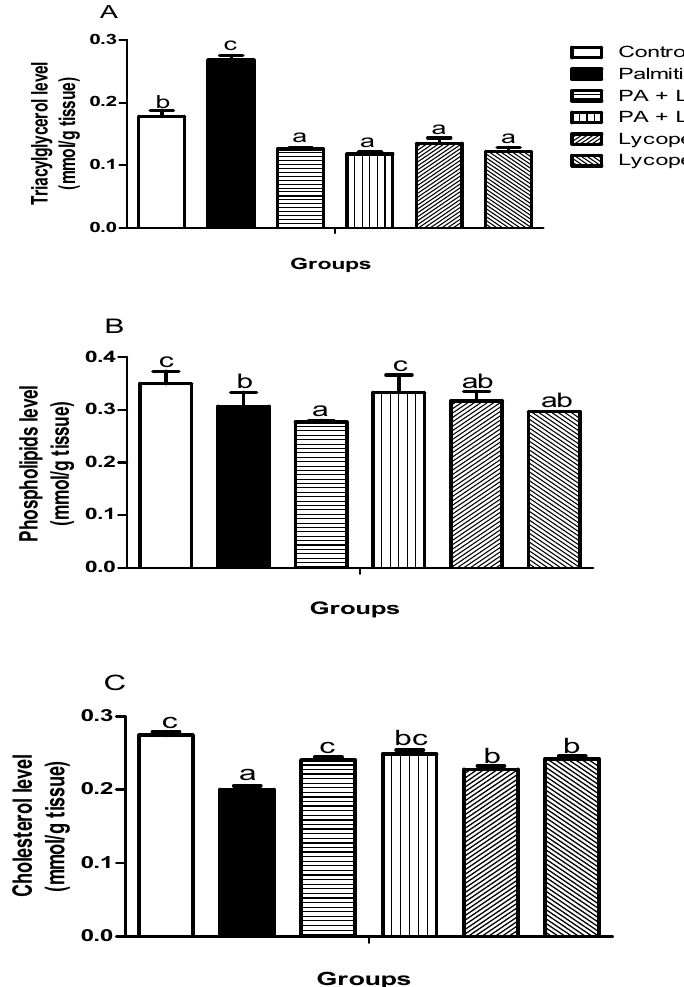
Figure 4. Effects of lycopene on brain lipid profiles of palmitic acid-induced neuro-inflammation in female rats. Values are expressed as mean ± S.E.M (n = 5). Bars with different letters are statistically distinct (p < 0.05). ( A ) Triacylglycerol level ( B ) Phospholipids level ( C ) Cholesterol level. Data were analysed using SPSS version 20 (IBM SPSS Software, United Kingdom) while the graph was plotted using GraphPad Prism Software, version 6 (San Diego, CA 92,108) https:// www. graph pad. com/ scien tific- softw are/